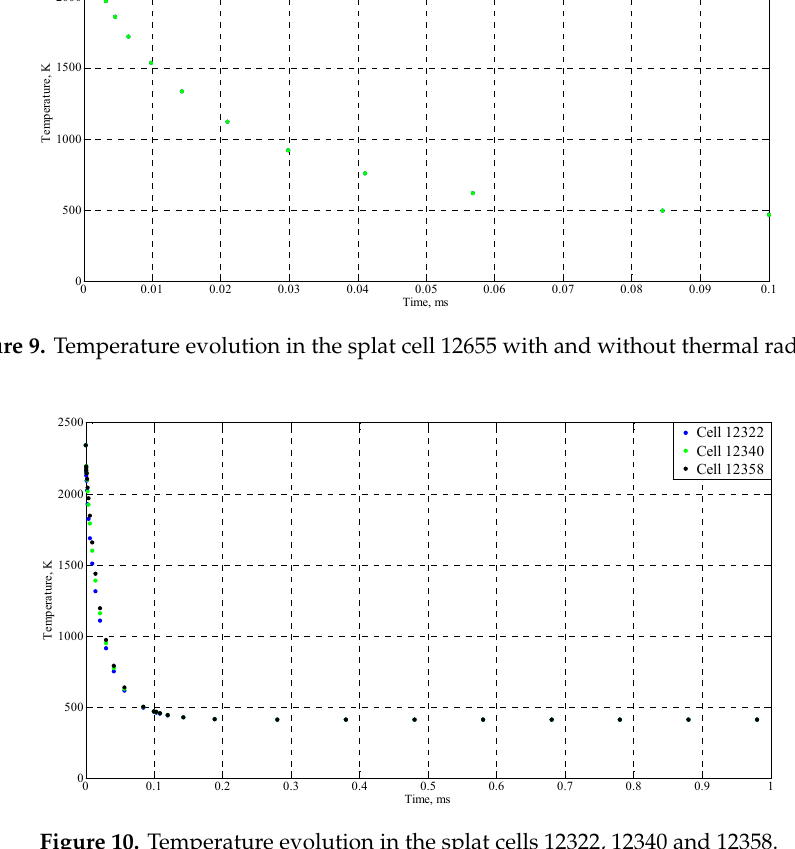
Figure 10. Temperature evolution in the splat cells 12322, 12340 and 12358.